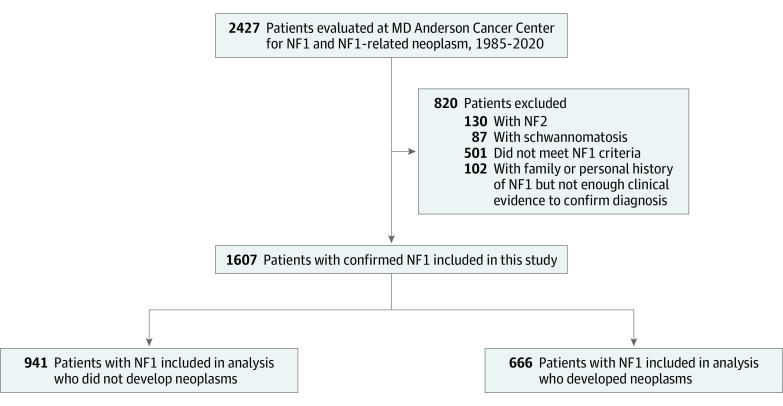
Flow Chart for Inclusion and Exclusion CriteriaNF1 indicates neurofibromatosis type 1; NF2, neurofibromatosis type 2.